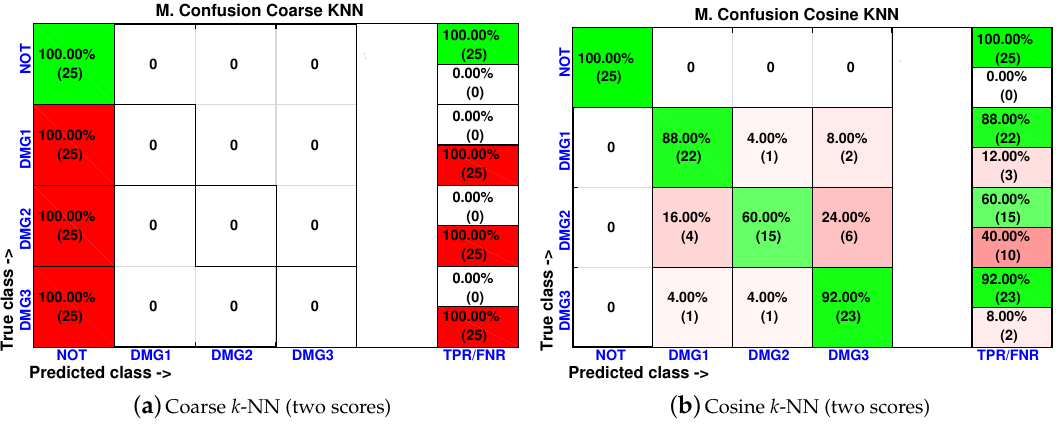
Figure 33. Confusion matrix using coarse k -NN ( a ) and cosine k -NN ( b ) when the feature vector is formed by the first two principal components.